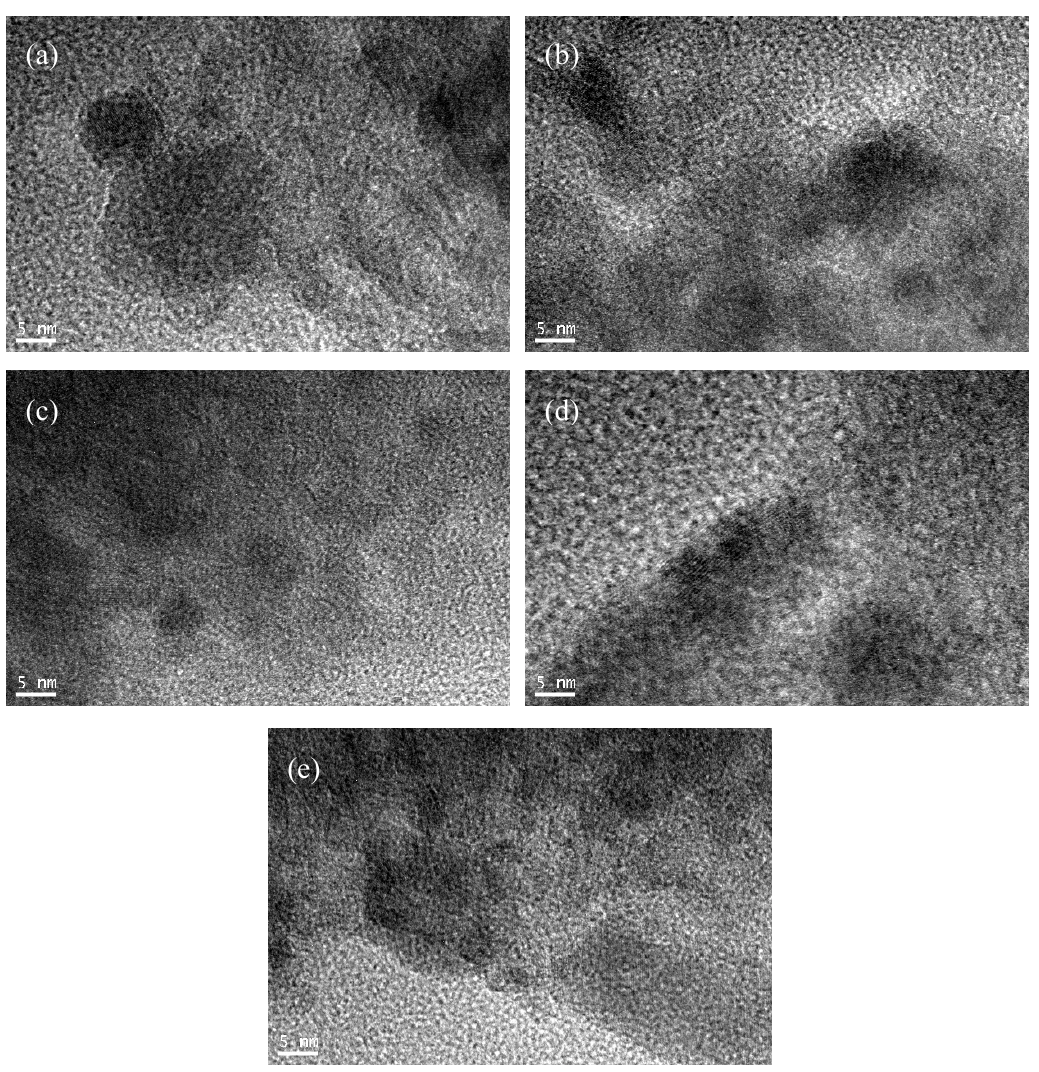
Figure 5. TEM images of 4% Ni/M100-MA ( a ), 6% Ni/M100-MA ( b ), 8% Ni/M100-MA ( c ), 10% Ni/M100-MA ( d ), and 12% Ni/M100-MA ( e ).